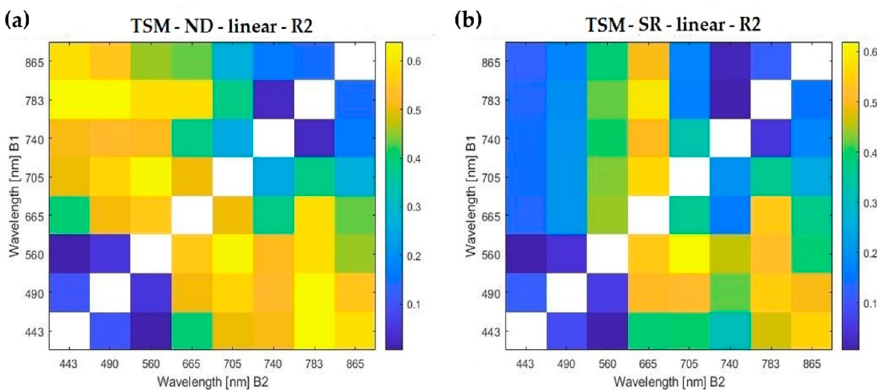
Figure 6. Correlation between TSM measured in the Júcar and Ebro reservoirs and TSM given by the C2RCC processor. In blue, line 1:1 is shown.